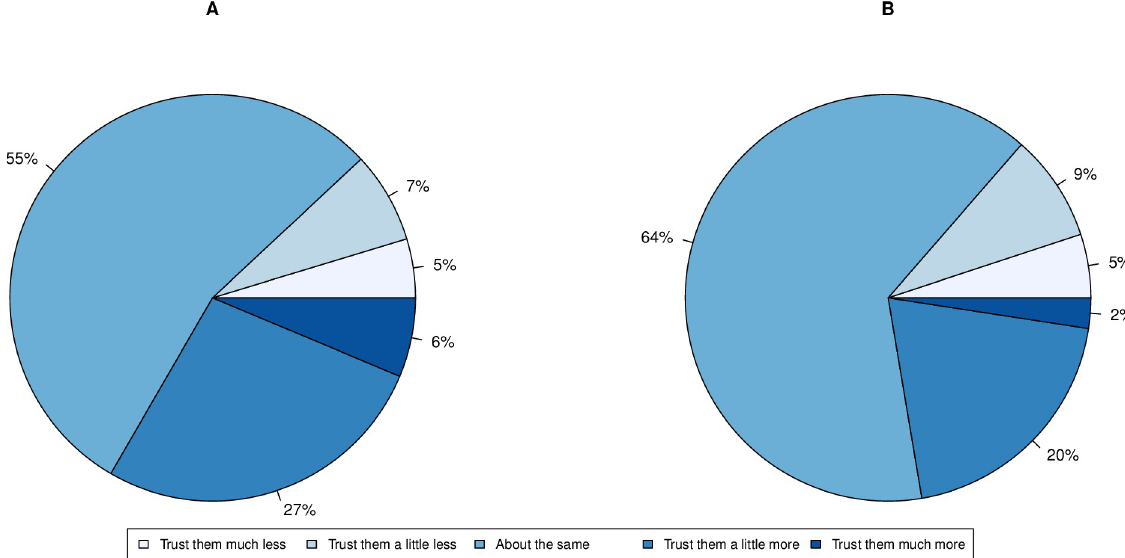
Fig 3. Proportion of individuals in each class of self-reported change in trust in pharmaceutical companies during the COVID-19 pandemic if given either A. Pfizer (N = 1046) or B. GlaxoSmithKline (N = 949) as exemplars.